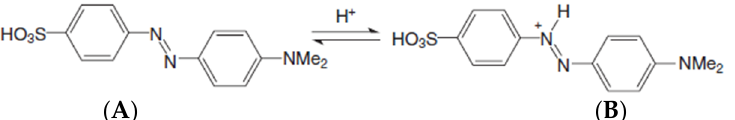
Figure 8. The colour change of MO dye from orange ( A ) to red ( B ) due to dye protonation.